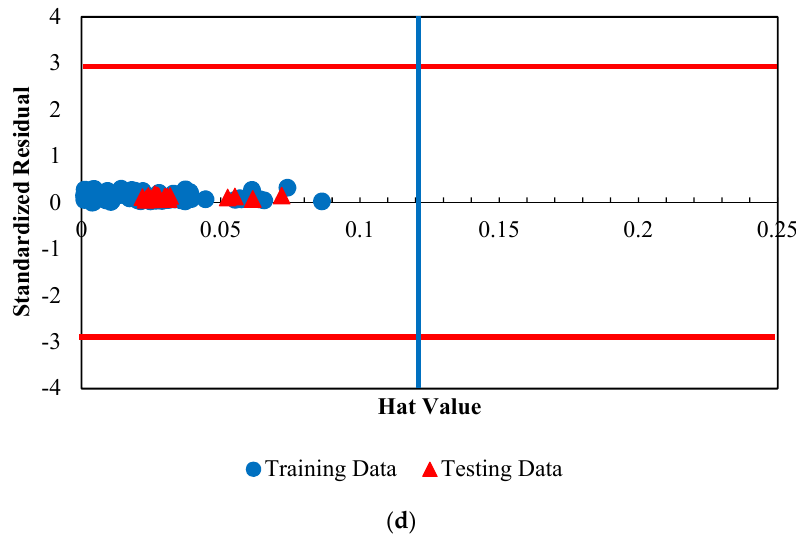
Figure 24. Detection of the probable doubtful measured viscosity and thermal conductivity data and the applicability domain of the suggested approaches for the viscosity of Fe 2 O 3 /ethylene glycol-water nanofluid. ( a ) GA-LSSVM model for viscosity prediction ( b ) PSO-ANN model for viscosity prediction ( c ) GA-LSSVM model for thermal conductivity prediction ( d ) PSO-ANN model for thermal conductivity prediction (the H* value is